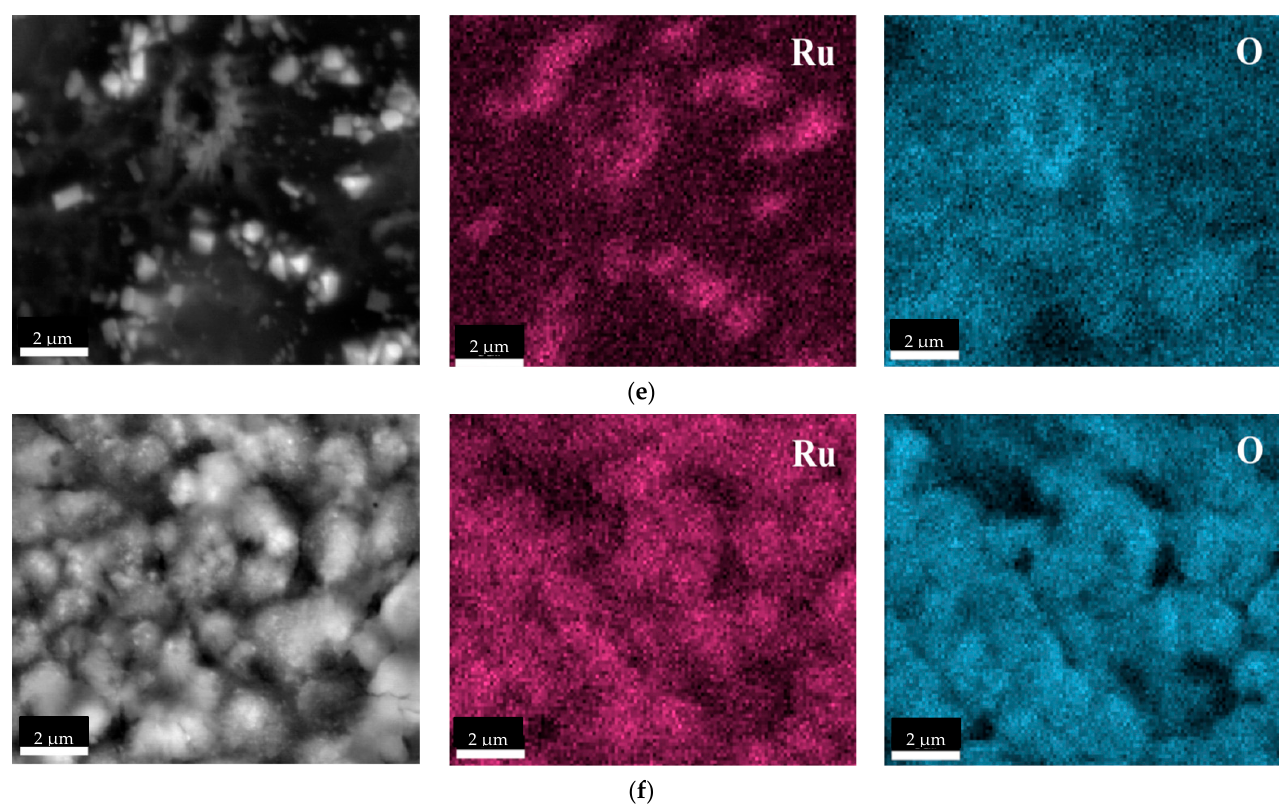
Figure A3. SEM coupled with EDS images of Pd-NP ( a , b ), Rh-NP ( c , d ) and Ru-NP ( e , f ) (molar ratio of PGM:PVP:reducer was 1:5:2) using AA for ( a , c , e ) and NaBH 4 for ( b , d , f ). TEM images of Rh/Ru-NP after a precipitation with AA and NaBH 4 are presented in Figure A4.